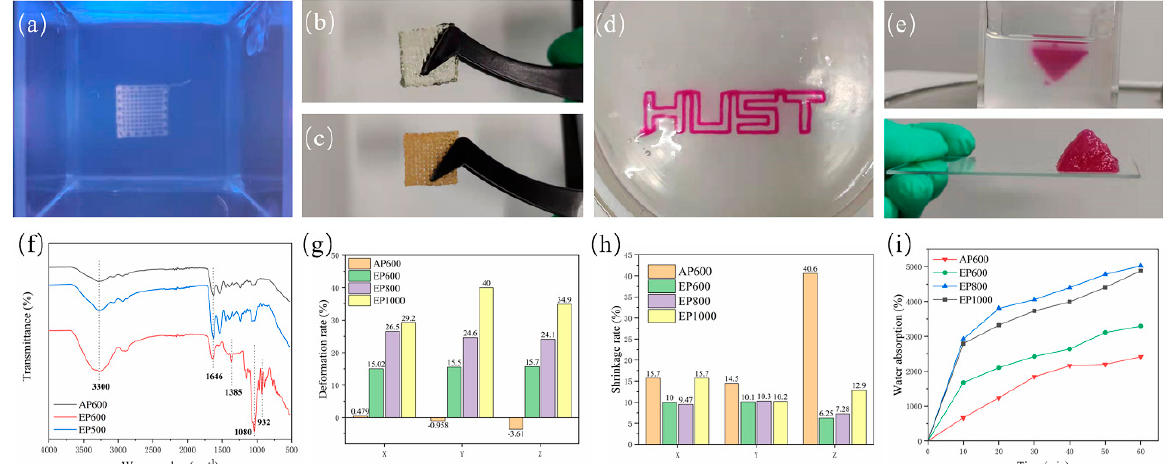
Figure 4. ( a ) Scaffold morphology in the support bath; ( b ) printed EP scaffold; ( c ) conventionally extruded scaffold; ( d ) extruded “HUST” hollow structure; ( e ) printed inverted triangle solid structure; ( f ) FTIR spectra of AP600, EP600, and EP500; ( g ) deformation rate after printing; ( h ) shrinkage rate after freeze-drying; ( i ) water absorption test for different scaffolds.